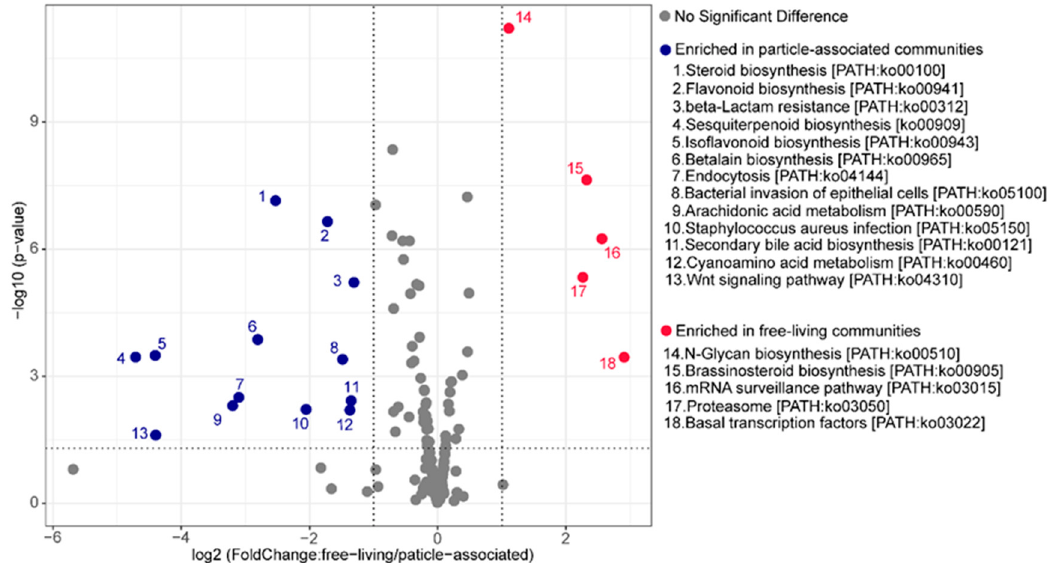
Figure 8. KEGG pathways predicted by PICRUSt2 to be enriched in the PA (blue) and FL (red) communities. Enriched pathways have an adjusted p -value < 0.05 and log2 fold change > 1 (twofold change), the metabolic pathways with no significant difference in PA and FL are indicated by gray circles.